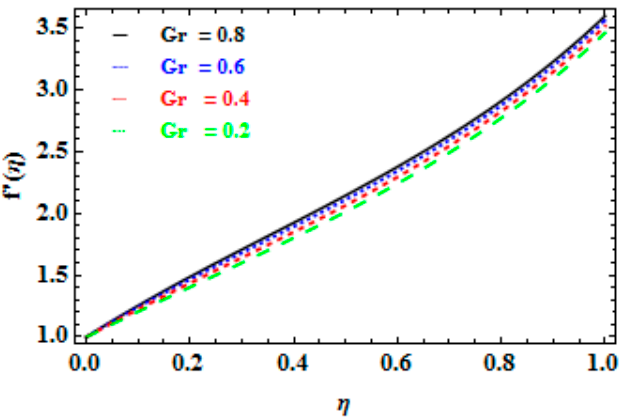
Figure 8. Influence of